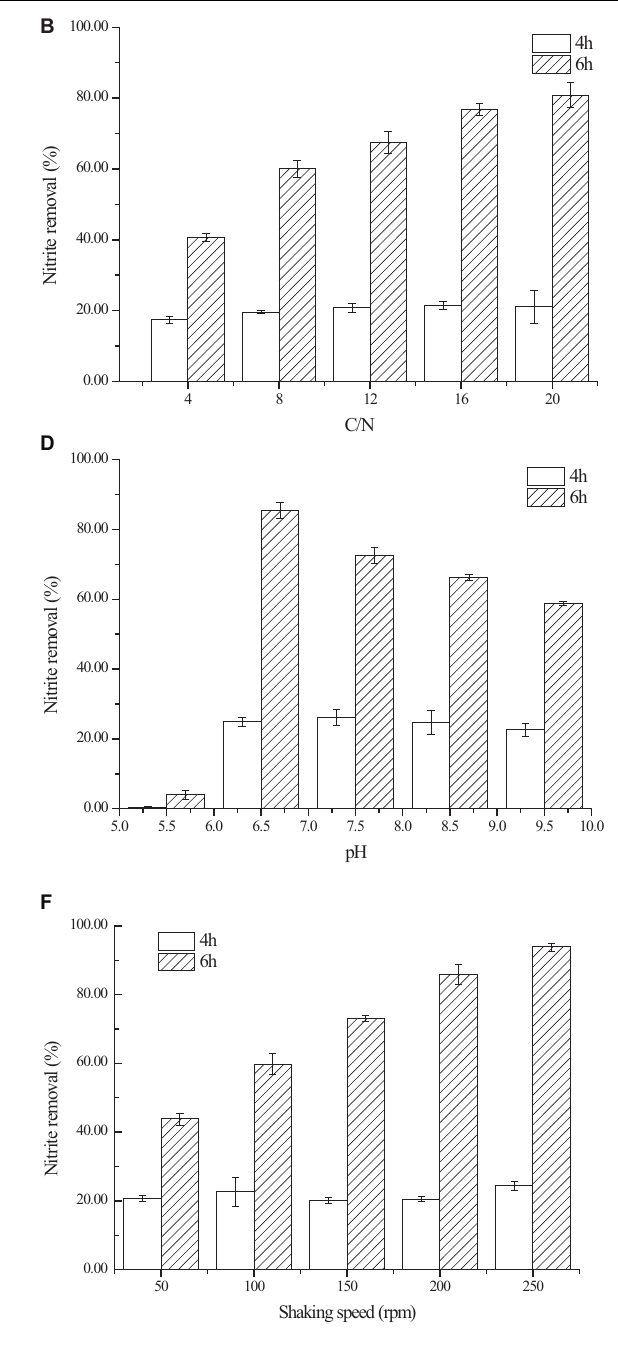
FIGURE 3 | Effect of different factors on nitrite denitrification by strain YT03. (A) Carbon source, (B) C/N ratio, (C) salinity, (D) initial pH, (E) temperature, and (F) shaking speed. Error bars mean ± SD of three